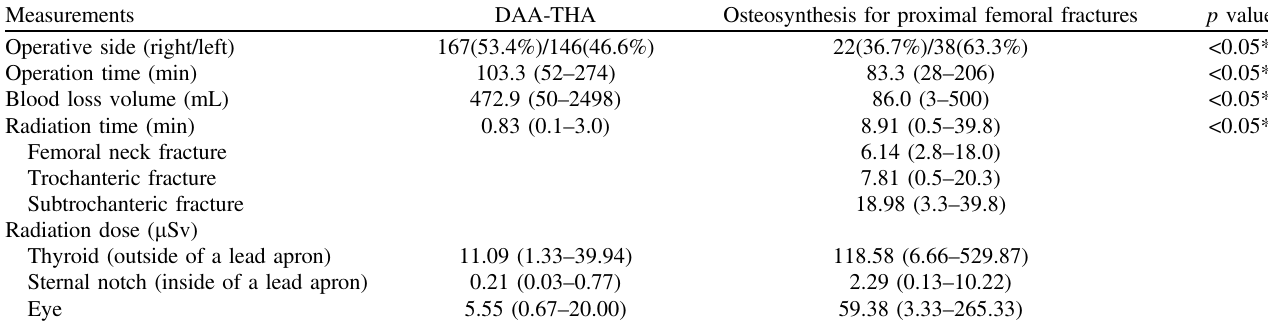
Table 2. Operation